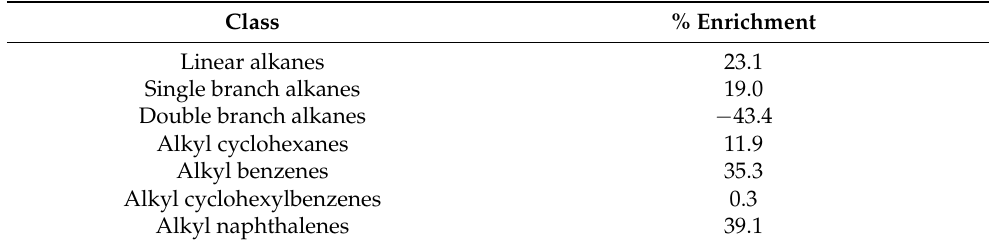
Figure 9. 2D-GC measurements [3] of the n-alkane separation coefficients versus retention time in the light shale crude oil separation. Table 6. Model predictions of molecular class enrichment in the permeate (Equation (16)) at 130 °C and 55 bar.